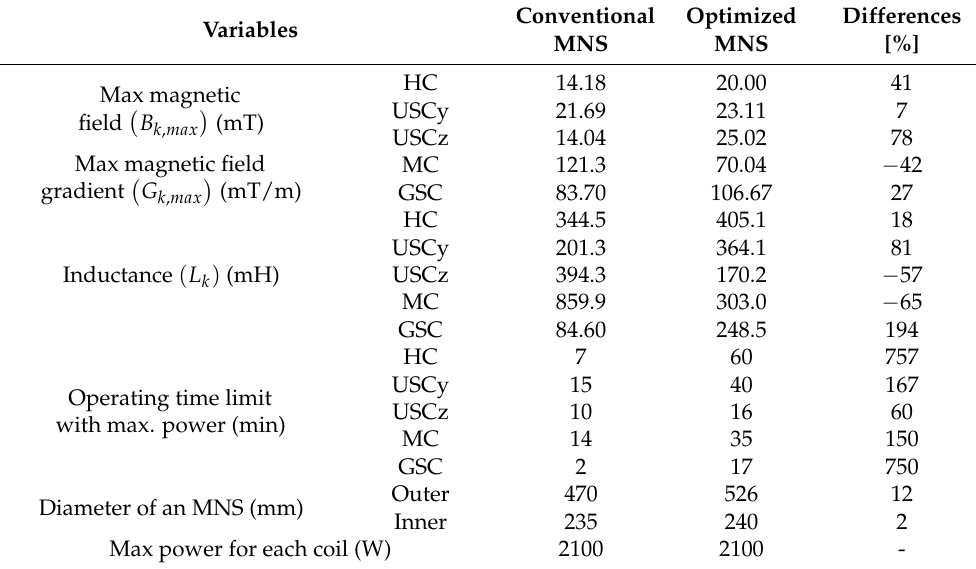
Table 4. Comparison of major values between the optimized and conventional MNS.